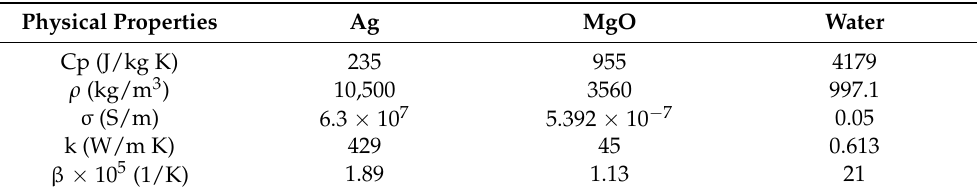
Table 2. The values of thermophysical characteristics of the Ag-MgO hybrid nanofluid and the base fluid Ma, et al. [43] and Ghalambaz, et al.